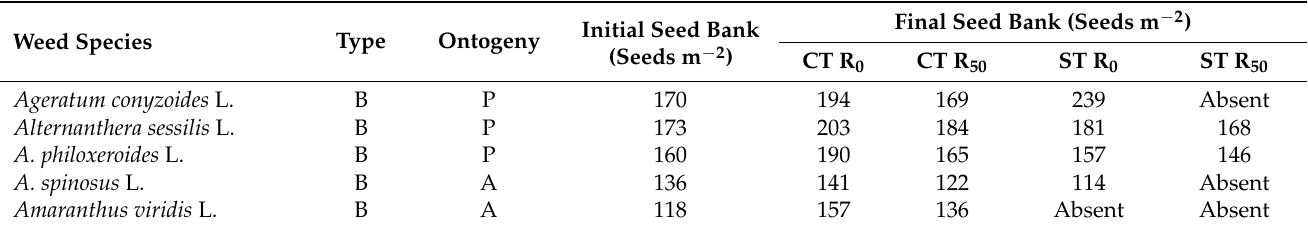
Table 3. Composition of initial and final soil seed bank at 0–5 cm depth under different treatments (average for wheat- mungbean-monsoon rice and monsoon rice-mustard-winter rice rotation). Weed